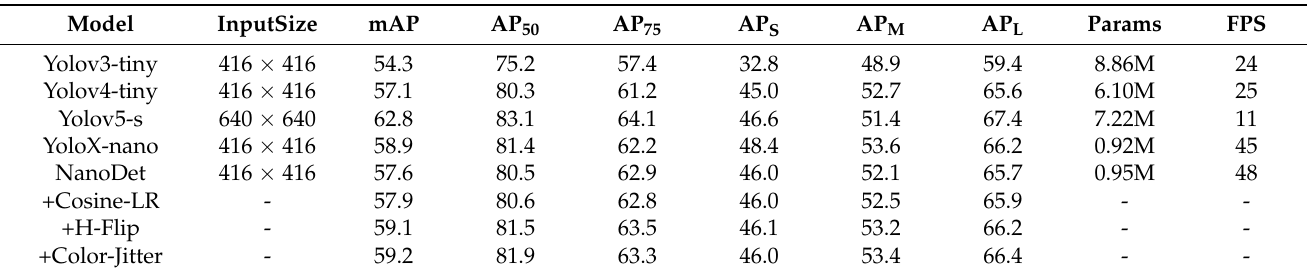
Table 2. Model evaluations on our fire dataset.